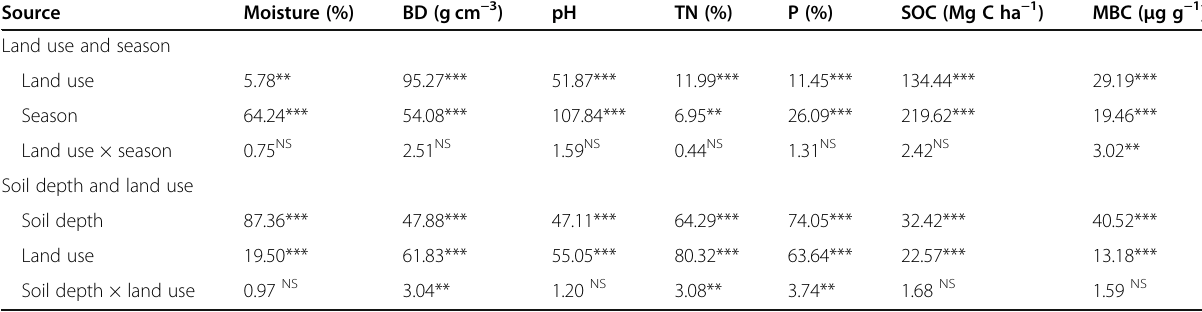
Table 2 Two-way ANOVAs showing significant differences in soil